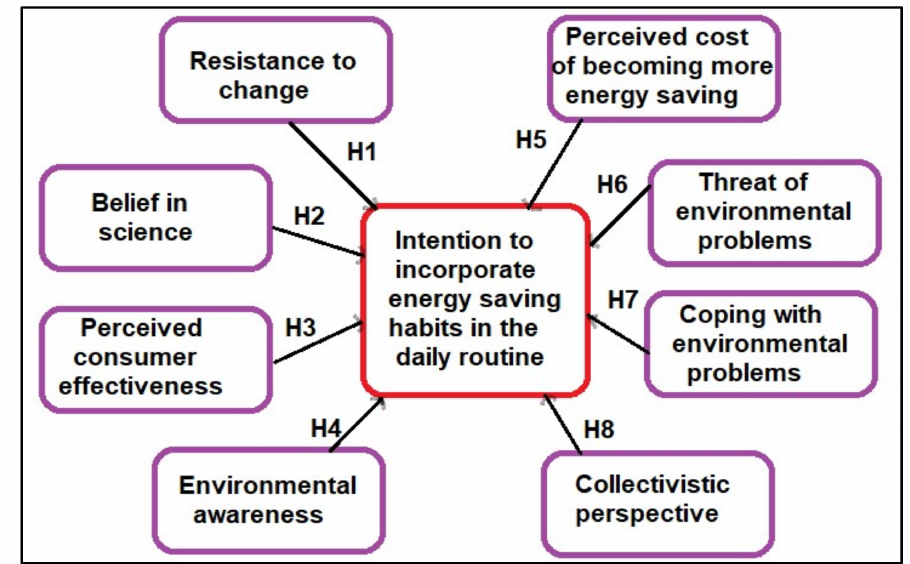
Figure 1. Overview of the hypotheses including the determinants with influence on the adoption of energy-saving habits by Romanian